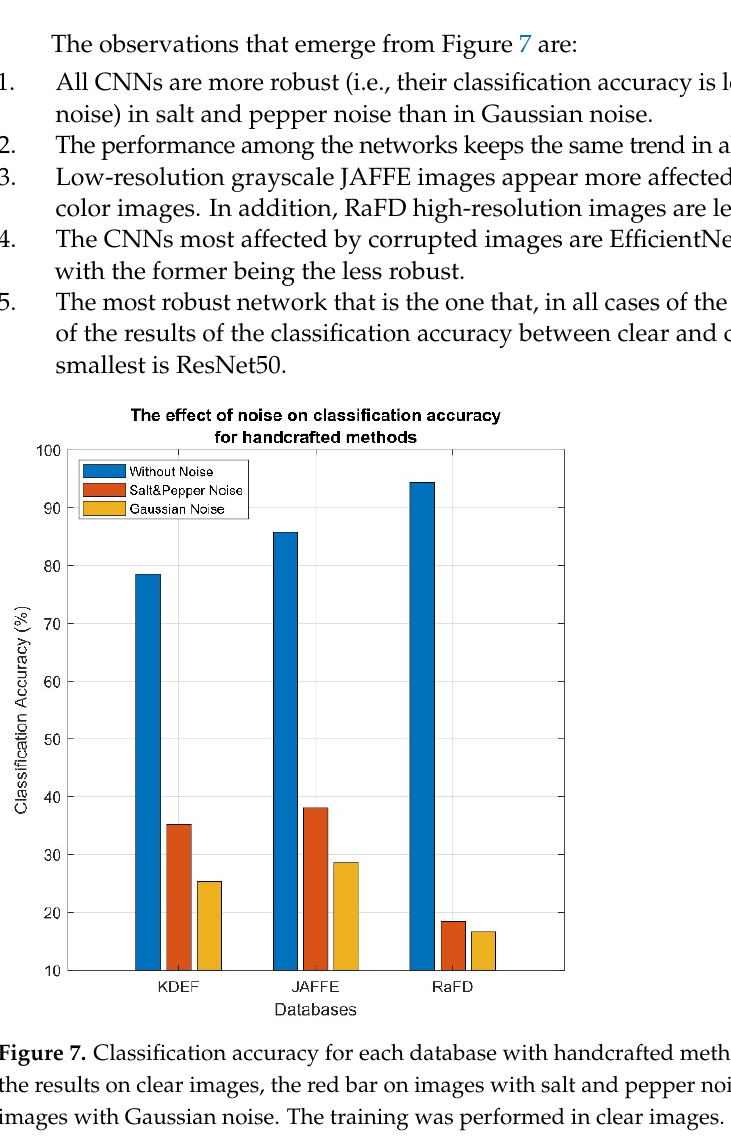
Table 7. Percentage deviation of classification accuracy with corrupted test images for each CNN per database.